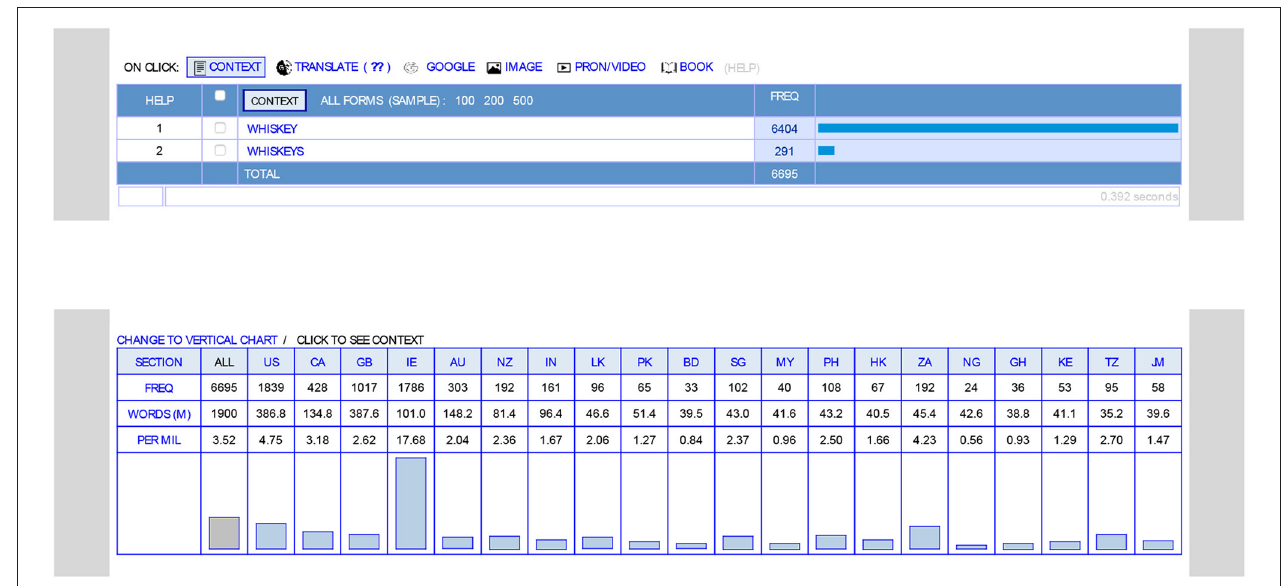
FIGURE 15 | Distribution of whiskey/whiskeys in the GloWbE Corpus (from https://www.english-corpora.org/glowbe/).